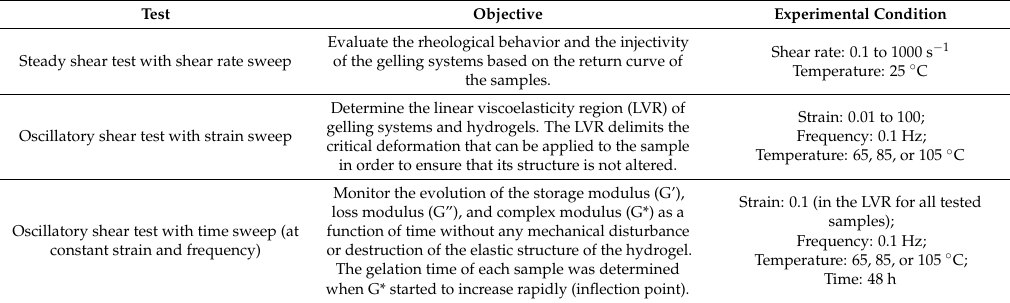
Table 6. Rheological tests applied to evaluate the gelling systems. Test Objective Experimental Condition Evaluate the rheological behavior and the injectivity Steady shear test with shear rate sweep of the gelling systems based on the return curve of the samples. Determine the linear viscoelasticity region (LVR) of gelling systems and hydrogels. The LVR delimits the critical deformation that can be applied to the sample in order to ensure that its structure is not altered. Monitor the evolution of the storage modulus (G’), loss modulus (G”), and complex modulus (G*) as a Oscillatory shear test with time sweep (at function of time without any mechanical disturbance constant strain and frequency) or destruction of the elastic structure of the hydrogel. The gelation time of each sample was determined when G* started to increase rapidly (inflection